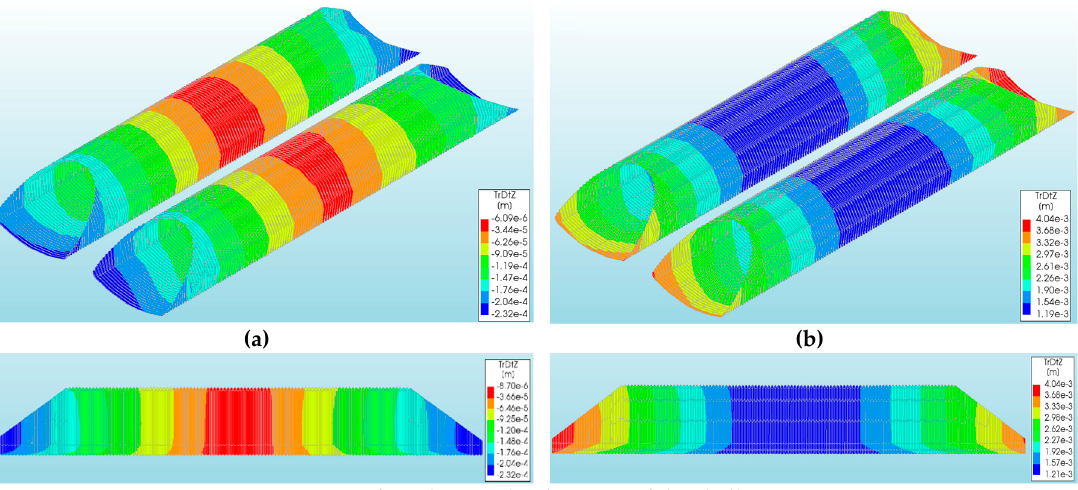
Figure 7. Maximal values of vertical displacements of CSP shell: ( a ) Rockburst for model Va, ( b ) El Centro for model Vb.